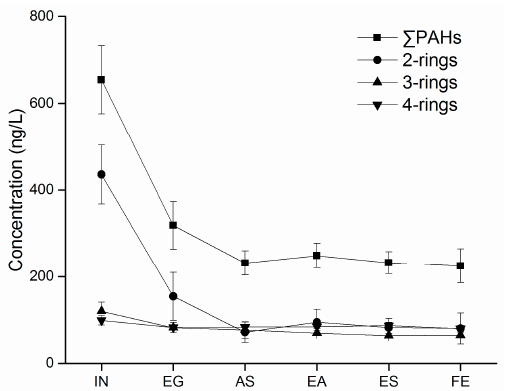
Figure 4. The variation of PAHs at different stages. Error bars represent 1 standard deviation of the mean.